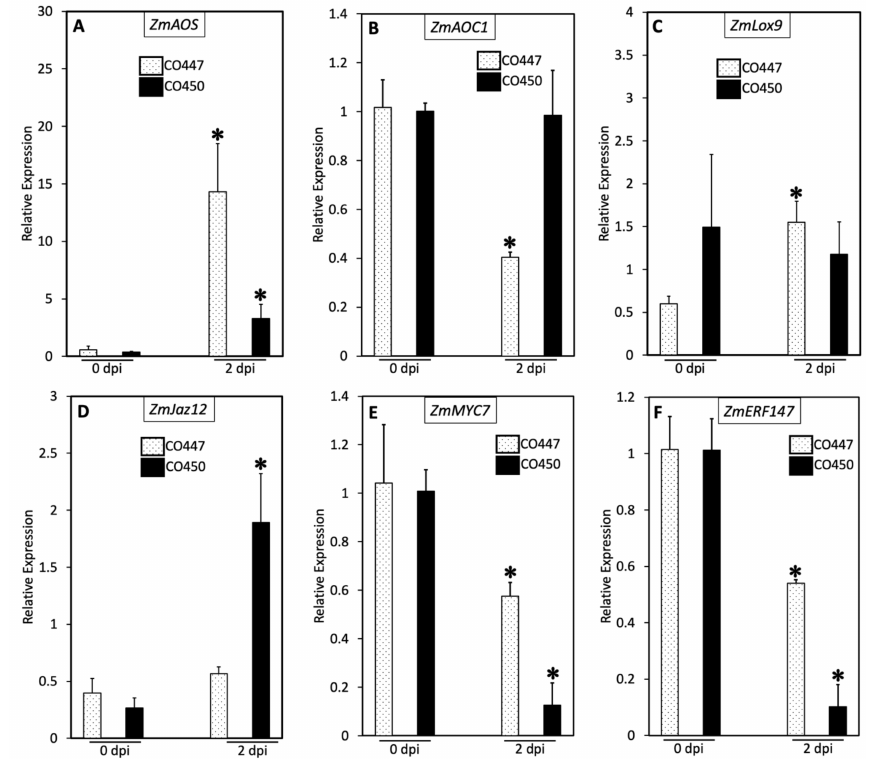
Figure 2. Induced resistance against Goss’s wilt disease in corn plants is not associated with the JA-dependent pathway. RT–qPCR analysis showing the transcript levels of the JA-regulated genes ZmAOS ( A ), ZmAOC1 ( B ), ZmLox9 ( C ), ZmJaz12 ( D ), ZmMYC7 ( E ), and ZMERF147 ( F ) in response to CMN14-5-1 of CO447 and CO450 corn lines. Leaves were sampled at 0 h and 48 h after treatments. Reference genes were Elongation Factor 1 ( EF1a ) for ( A , C , D ) and Actin for ( B , E , F ). The results are representative of three biological replicates. The error bars represent the standard error. Asterisks denote significant differences; * p <